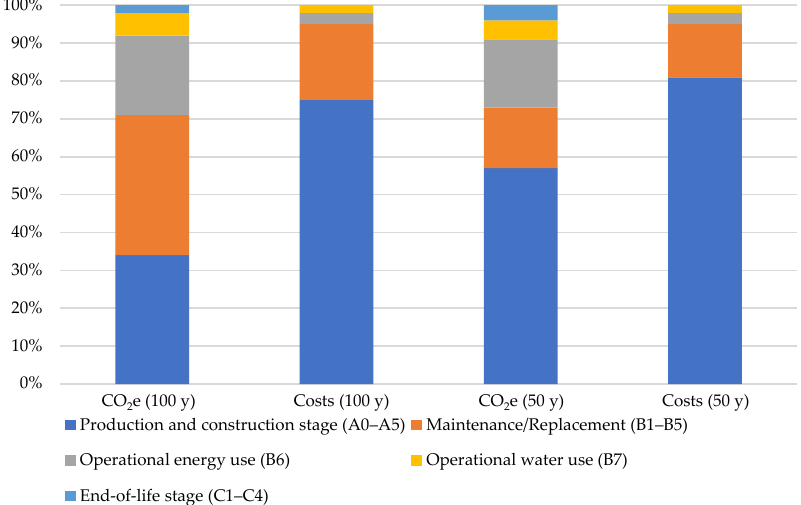
Figure 8. Integration of LCA and LCC results.